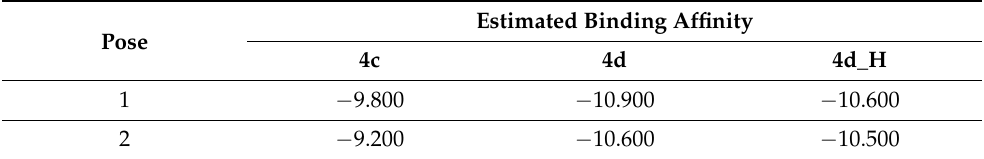
Table 2. Estimated binding affinity [kcal/mol] for the first two poses of the DCL–OAO derivative conjugates generated during the docking procedure; 4d_H —protonated form of the ( 4d ) derivative.